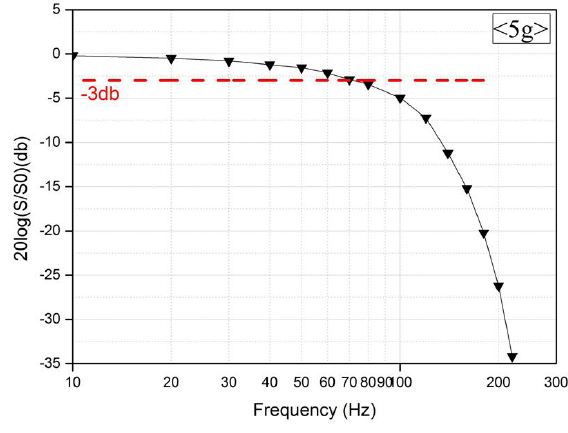
Figure 6 . Frequency characteristics of the accelerometer.